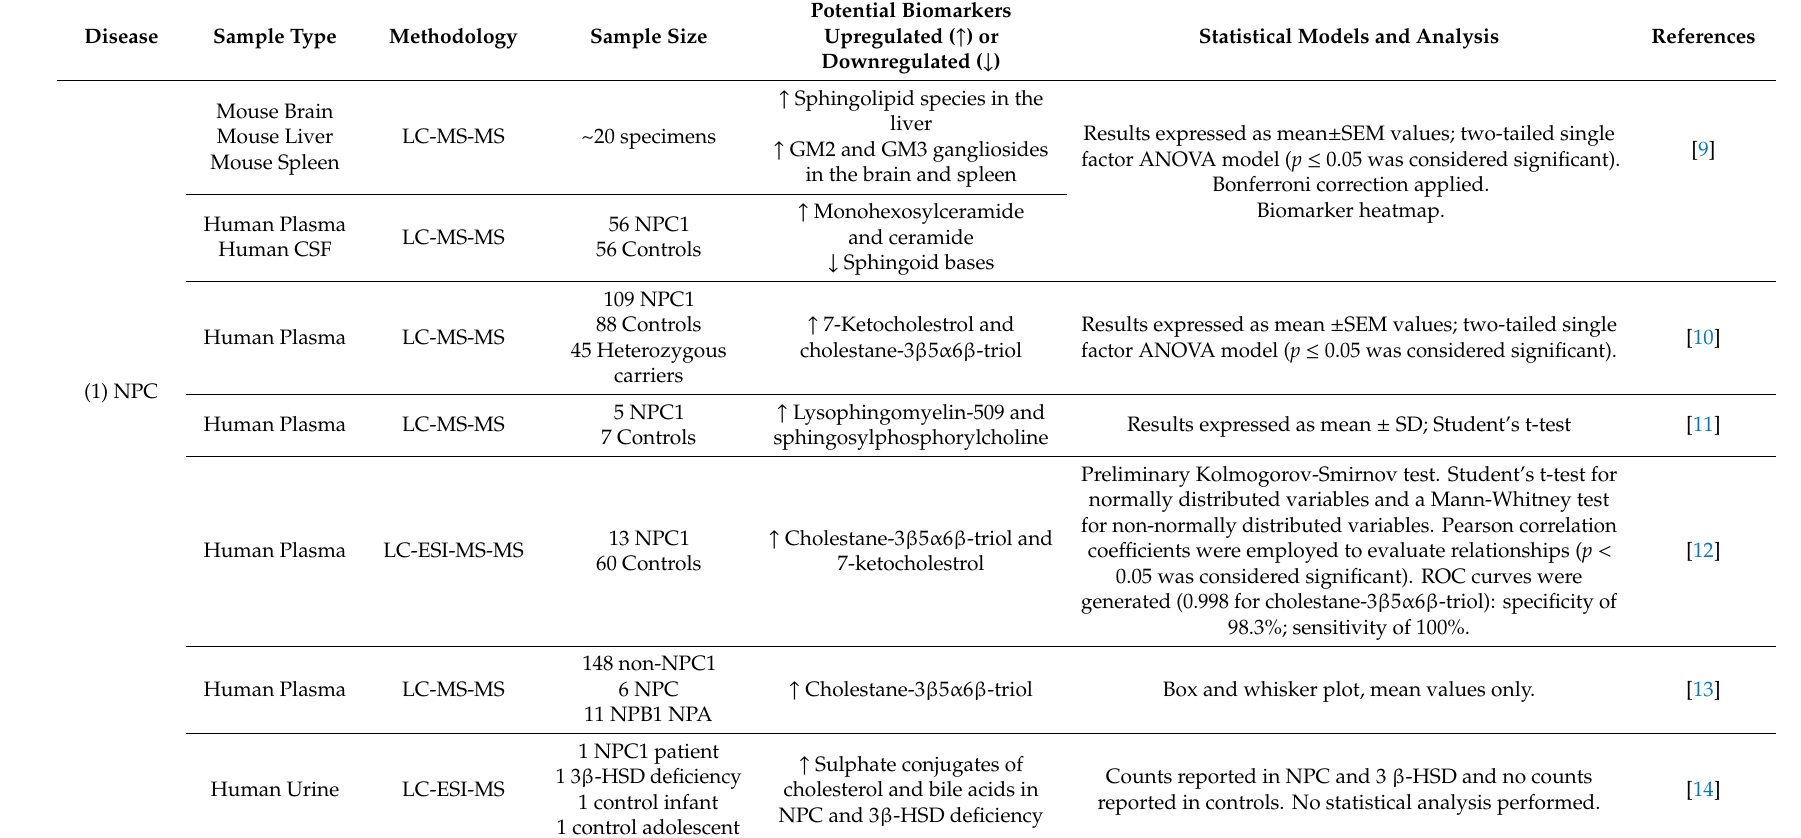
Table 2. Biomarkers for lipid storage